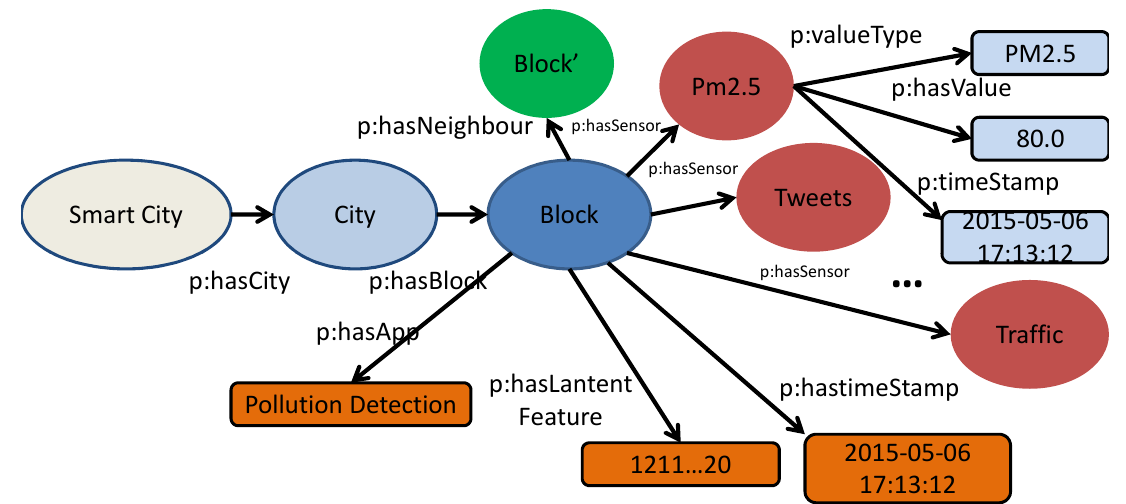
Figure 2. Simple concept model of urban knowledge